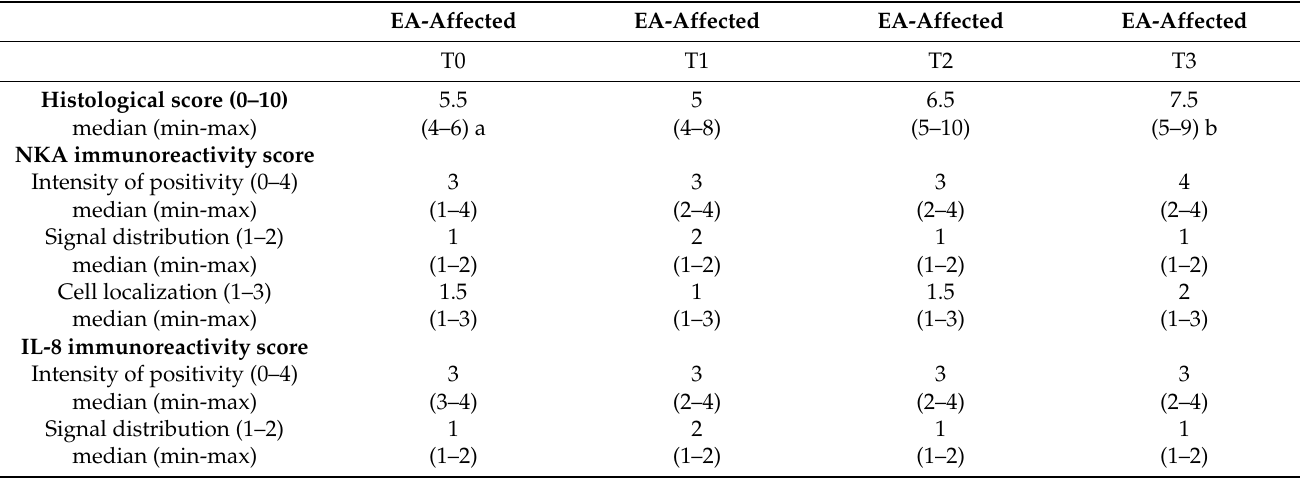
Table 3. Comparison of median value (min-max) of histological, NKA and IL-8 immunoreactivity scores acquired from bronchial biopsies, between EA-affected horses at T0, T1, T2, T3. Friedman test with Dunn’s multiple comparison test as post hoc test. a,b: different letters indicate significant differences ( p <